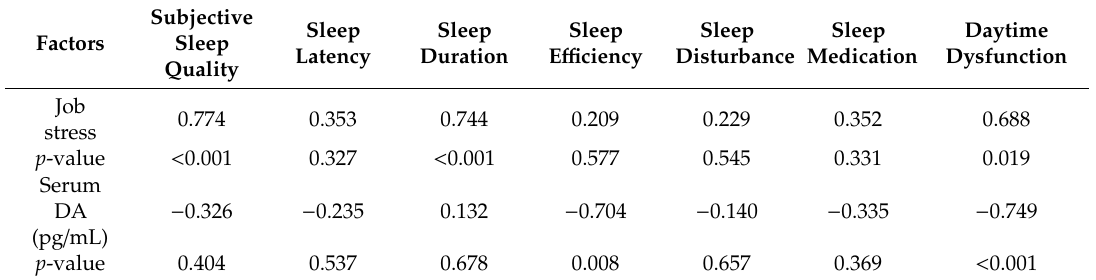
Table 3. Correlations between job stress, serum DA, and sleep